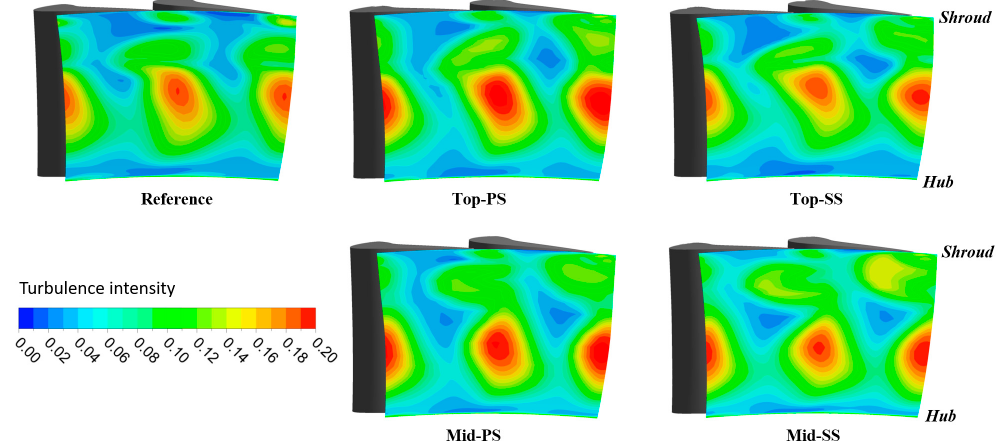
Figure 5. Contour of the turbulence intensity of the flow at the R1 outlet under various rotor blade conditions.